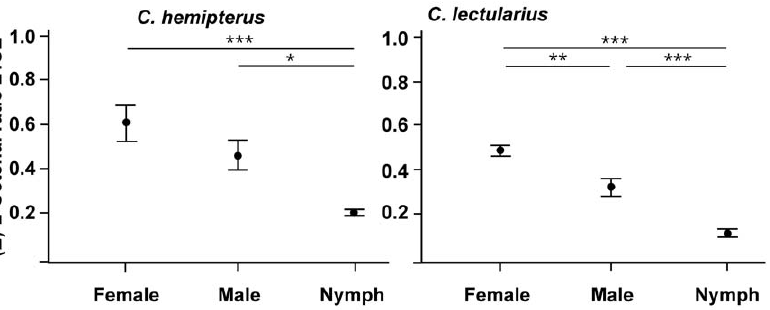
Figure 2. Aldehyde ratios in head space collections of C.hemipterus and C.lectularius . Mean ( E )-2-hexenal:( E )-2-octenal ratios present in the head space collections of C. hemipterus and C. lectularius females, males and nymphs. Asterisks correspond to statistical differences measure by Tukey’s post hoc test with * P , 0.05, ** P , 0.01 and *** P , 0.001. There is no significant difference when comparing groups between species (ANOVA; F 2,67 =0.031; P =0.970).